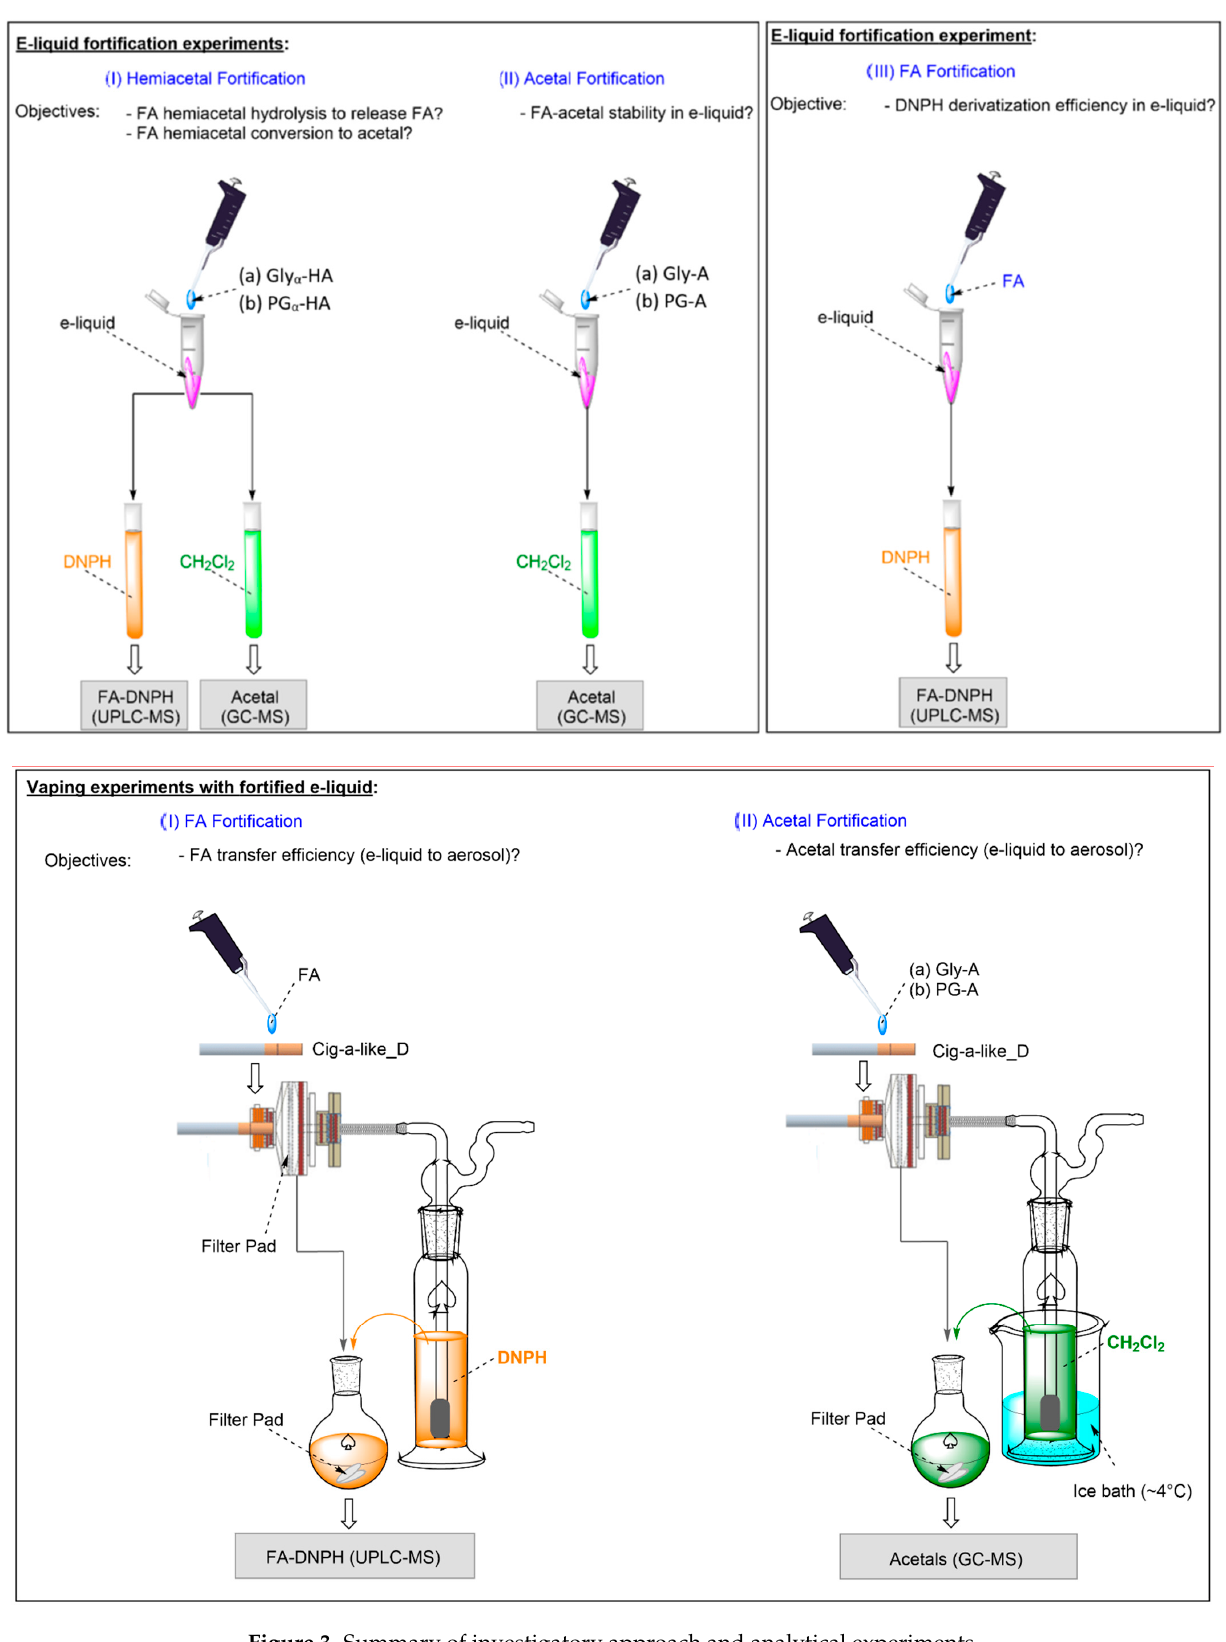
Figure 3. Summary of investigatory approach and analytical experiments.